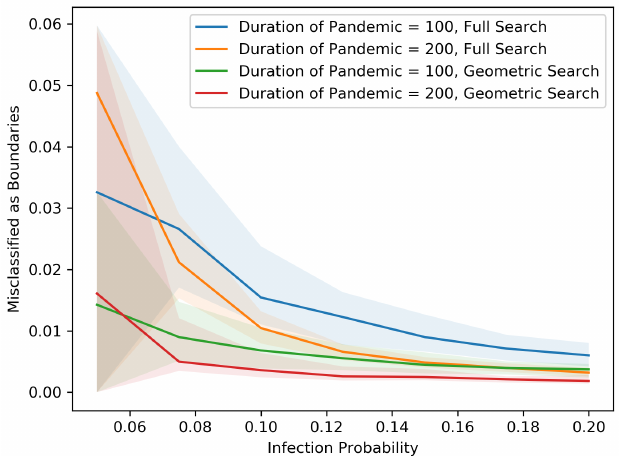
Figure 9. Misclassified As Boundaries. Population = 250,000 Non-cooperative Rate = 0. N: number of people inside and containing the external boundary.